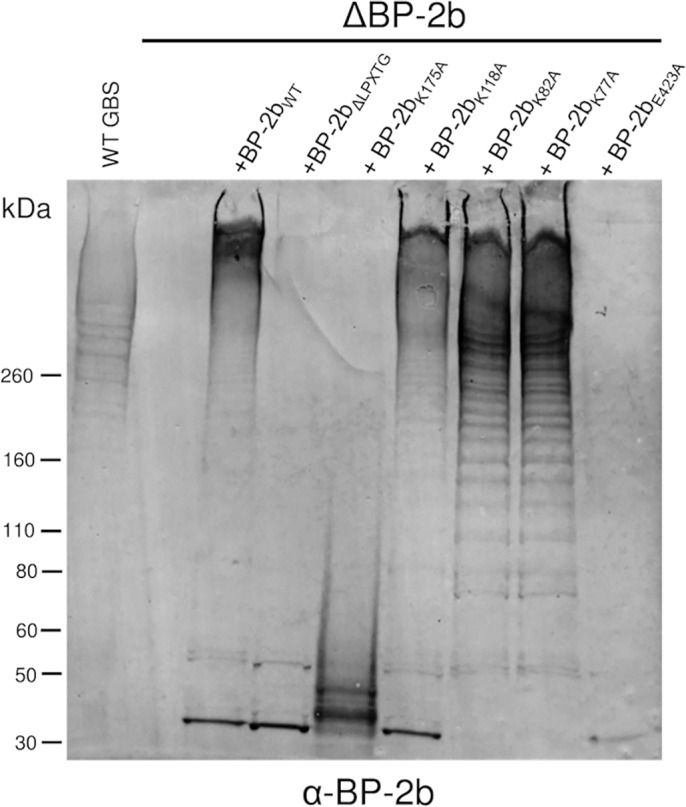
Lys 175, Glu 423 and the sorting motif LPSTG are involved in BP-2b polymerization in GBS.Immunoblot analysis of total protein extracts from GBS mutant strain lacking the pilus 2b backbone protein gene (ΔBP-2b) complemented with plasmids expressing the wild-type BP-2b protein (WT) or BP-2b mutants carrying a deletion of the C-terminal sorting signal (BP-2bΔLPXTG), alanine substitutions of the putative pilin motif lysine (BP-2bK175A, BP-2bK118A BP-2bK82A) or of the E-box E423 residue (BP-2bE423A). Nitrocellulose membrane was probed with a mouse antiserum raised against the recombinant BP-2b protein (α-BP–2b).